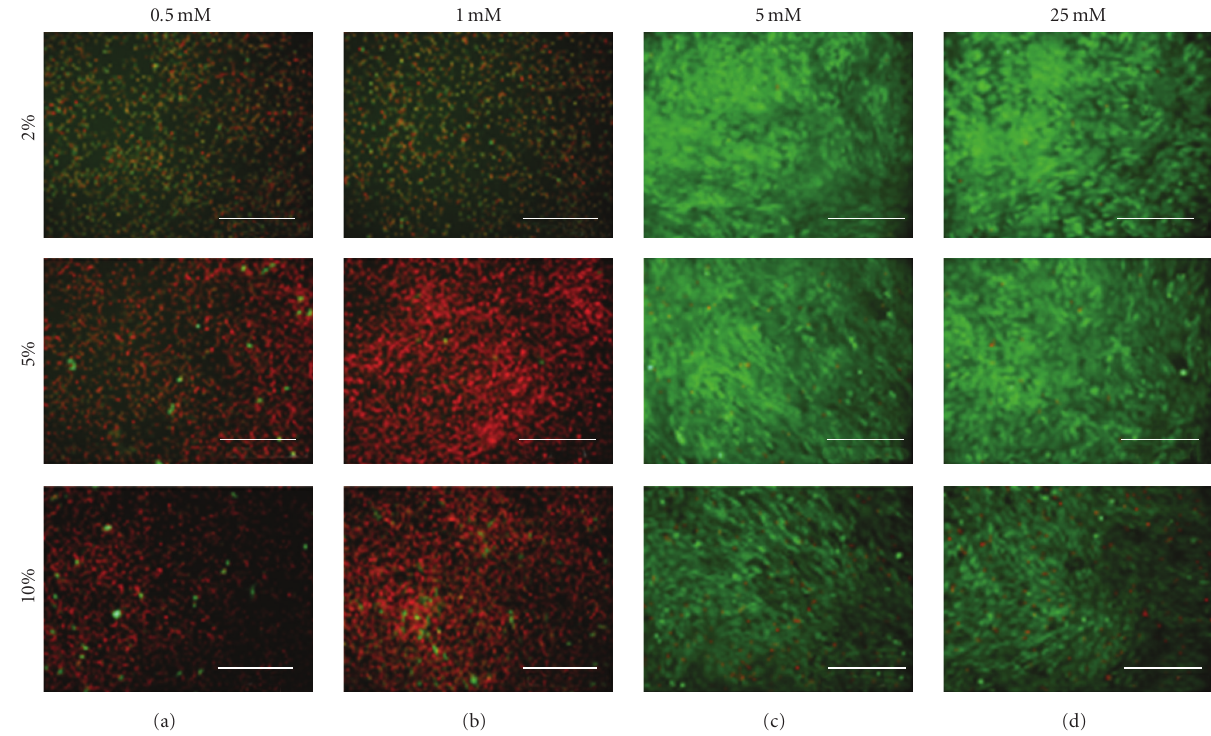
Figure 3: Fluorescence microscopy images indicating the viability of BMSCs in two-dimensional culture after the second day (increasing glucose concentrations from left to right; increasing serum concentrations from top to bottom). Calcein-AM indicates living cells by emitting green light, while ethidium bromide indicates dead cells by emitting red light. The 0.5mM and 1.0mM environmentsresulted in low viability and sparse cell distribution. The 5.0mM and 25.0mM environments resulted in high viability and the maintenance of high confluency. Varying the serum concentration did not produce a noticeable di ff erence in the viability. This result was consistent throughout the course of the week (20x objective; scale bar represents 250 μ